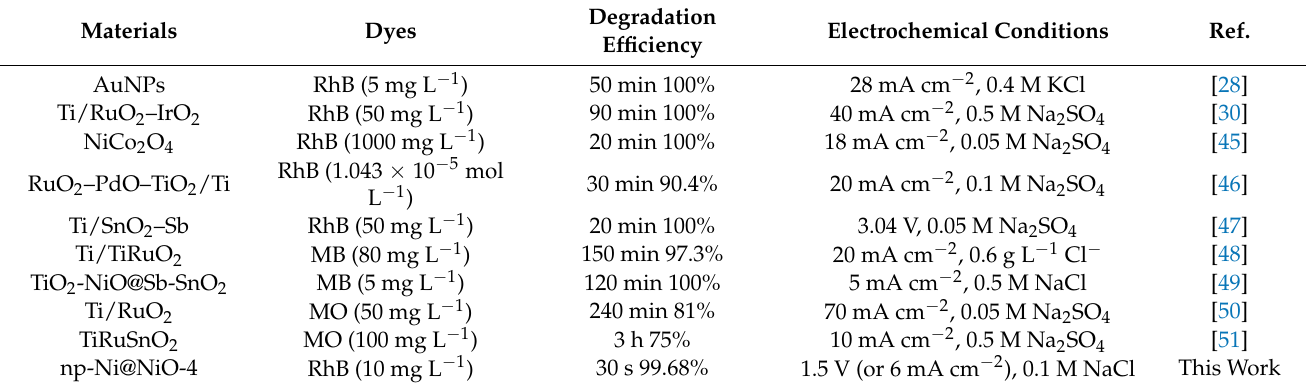
Table 1. Comparison of electrochemical degradability among different electrodes